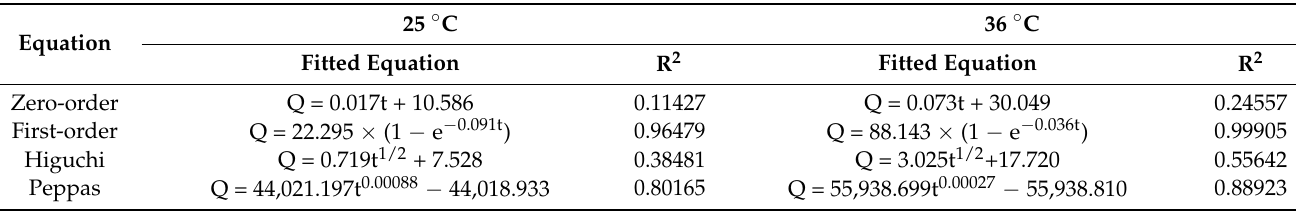
Figure 3. The release curves and fitting results of P/Cn8. Table 3. Kinetic fitting